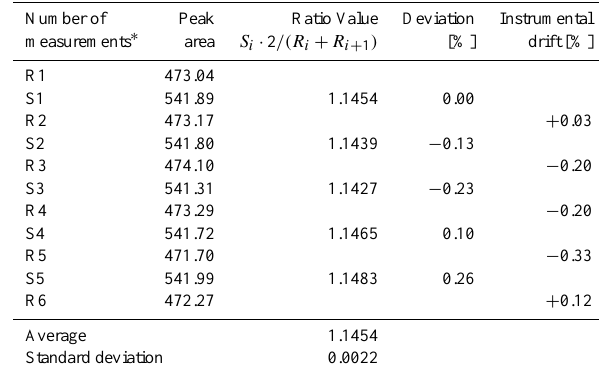
Table 1. Repeated measurement of reference and sample in order to compensate for instrumental drift between measurement cycles; every area data point is a result of three successive analyses.